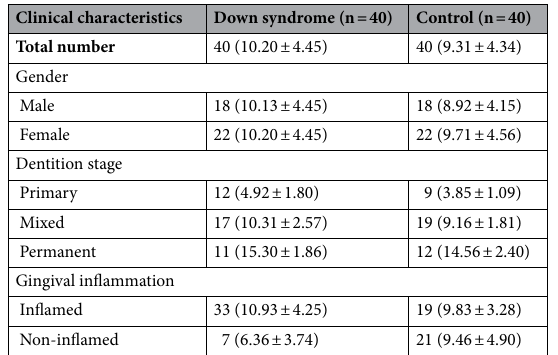
Table 1. Number of study subjects. Numbers in parentheses indicate mean ± SD of